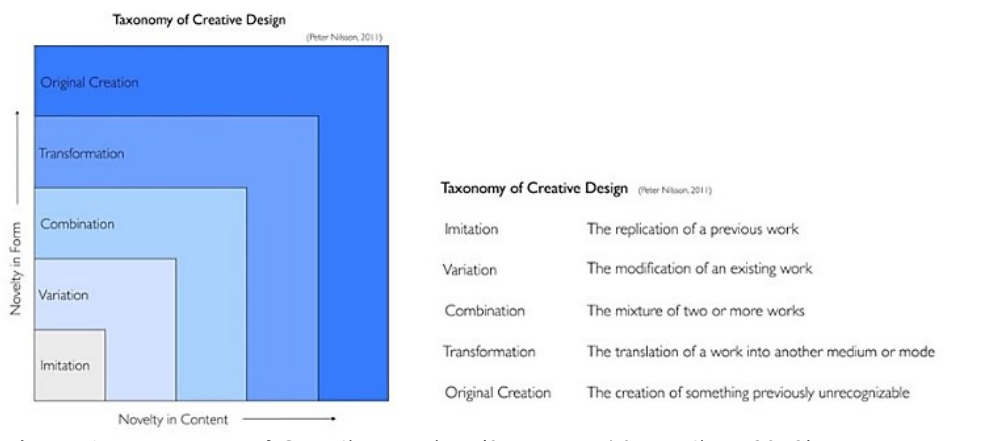
Figure 6. Taxonomy of Creative Design (Sense and Sensation,